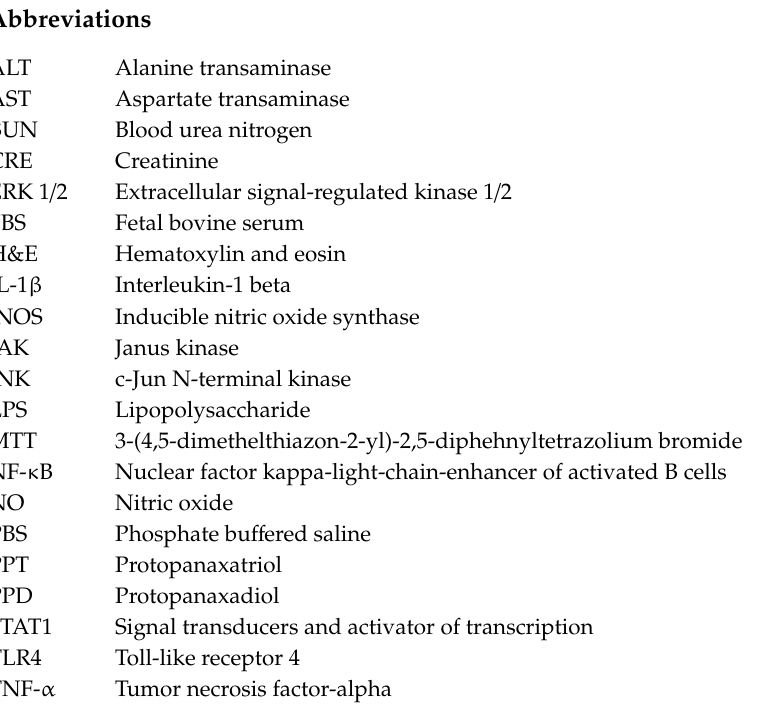
Figure S1: E ff ect of ginsenosides Rg2 and Rh1 on activation of MAPK signaling in LPS-stimulated macrophages; Figure S2: Inhibitory e ff ect of Rg2 and Rh1 on cytokine productions in plasma of LPS-stimulated